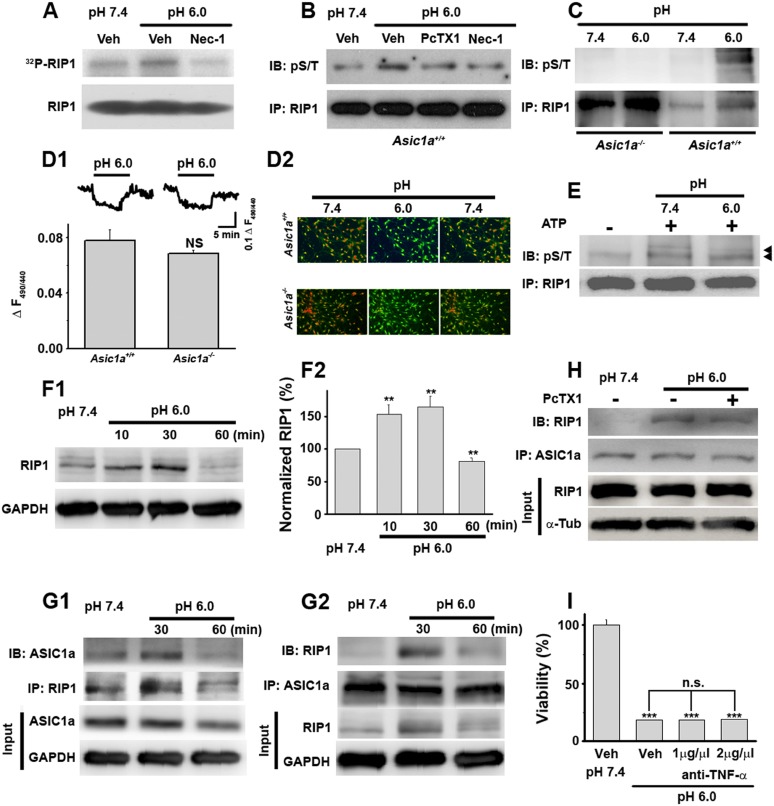
Acid (pH 6.0) induces RIP1 phosphorylation and physical association between RIP1 and ASIC1a.(A) Acid-induced phosphorylation of RIP1 and its inhibition by 40 μM Nec-1, as measured by 32P incorporation. (B) Acid-induced phosphorylation of RIP1 and its inhibition by Nec-1 (40 μM) and PcTX1 (50 nM), detected using the anti-phospho S/T antibody. (C) Acid failed to induce RIP1 phosphorylation in neurons from Asic1a−/− mice. Five-fold more proteins were loaded for Asic1a−/− samples than for Asic1a+/+ samples. (D1, D2) Time courses (D1) and representative ratio images (D2) of intracellular acidification of cultured mouse cortical neurons from Asic1a+/+ and Asic1a−/− mice in response to extracellular pH decrease from 7.4 to 6.0, monitored using BCECF (n=30 for each genotype, peak changes summarized in D1). (E) In vitro RIP1 phosphorylation assay in pH 7.4 and pH 6.0 reaction solutions. Bands for phosphorylated RIP1 are indicated by the arrowheads. (F1, F2) Acid altered RIP1 expression levels with time. Shown are representative blots (F1) and summary data (F2) (n=5, **p<0.01 vs pH 7.4, by paired t test). (G1, G2) pH 6.0 treatment caused association of RIP1 with ASIC1a (G1, IP (immunoprecipitation) RIP1, IB (immunoblotting) ASIC1a; G2, IP ASIC1a, IB RIP1). (H) PcTX1 disrupted acid-induced ASIC1a–RIP1 association. (I) TNF-α neutralizing antibody (1 μg/μl and 2 μg/μl) failed to rescue pH 6.0 solution-induced neuronal death (CTB assay, n=3, ***p<0.001 vs vehicle (Veh) at pH 7.4; n.s., no statistical significance, vs Veh at pH 6.0).